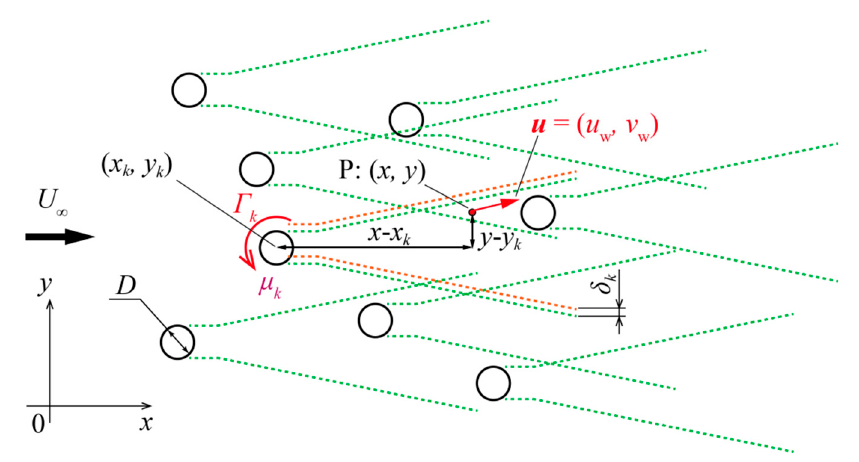
Figure 1. Schematic image of a wind farm of vertical-axis wind turbines (VAWTs). If an arbitrary set of the conditions of circulation ( Γ k ) and blockage effect ( µ k ) is given for a wind farm, the complex velocity potential W ( z ), where z = x + iy is expressed by Equation (1) [23].